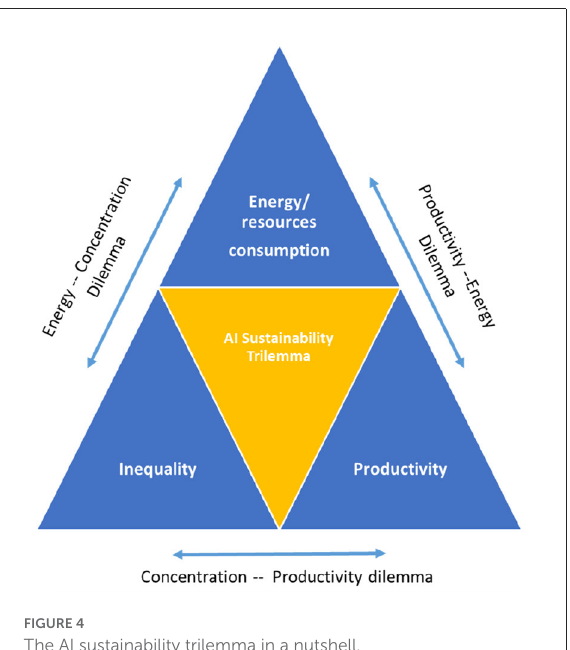
FIGURE4 The AI sustainability trilemma in a